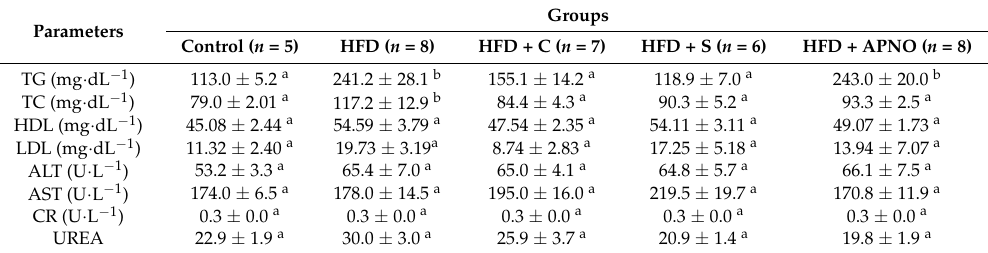
Table 4. The biochemical, hepatic, and renal parameters of normolipidemic rats (Control) and high-fructose-diet-induced hyperlipidemic rats treated with water (HFD), ciprofibrate (2 mg · Kg − 1